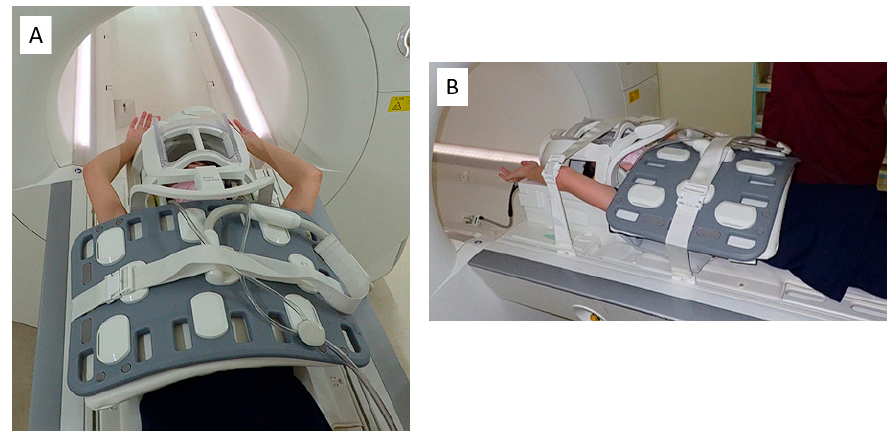
Figure 2. MRI imaging limb position. ( A ) The patient is placed in a supine position with the upper limb further elevated than in the Wright test position. ( B ) The upper extremities from the trunk are secured. MRI, magnetic resonance imaging.